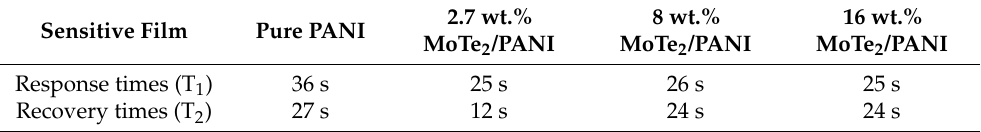
Figure 7. Dynamic response–recovery curves of gas sensors based on ( a ) the pure PANI, ( b ) 2.7 wt.% MoTe 2 /PANI composites, ( c ) 8 wt.% MoTe 2 /PANI composites and ( d ) 16 wt.% MoTe 2 /PANI composites when exposed to a 100 ppm concentration of NH 3 gas in a laboratory environment. Table 2. Response times (T1) and recovery times (T2) of sensors under 100 ppm NH 3 gas.